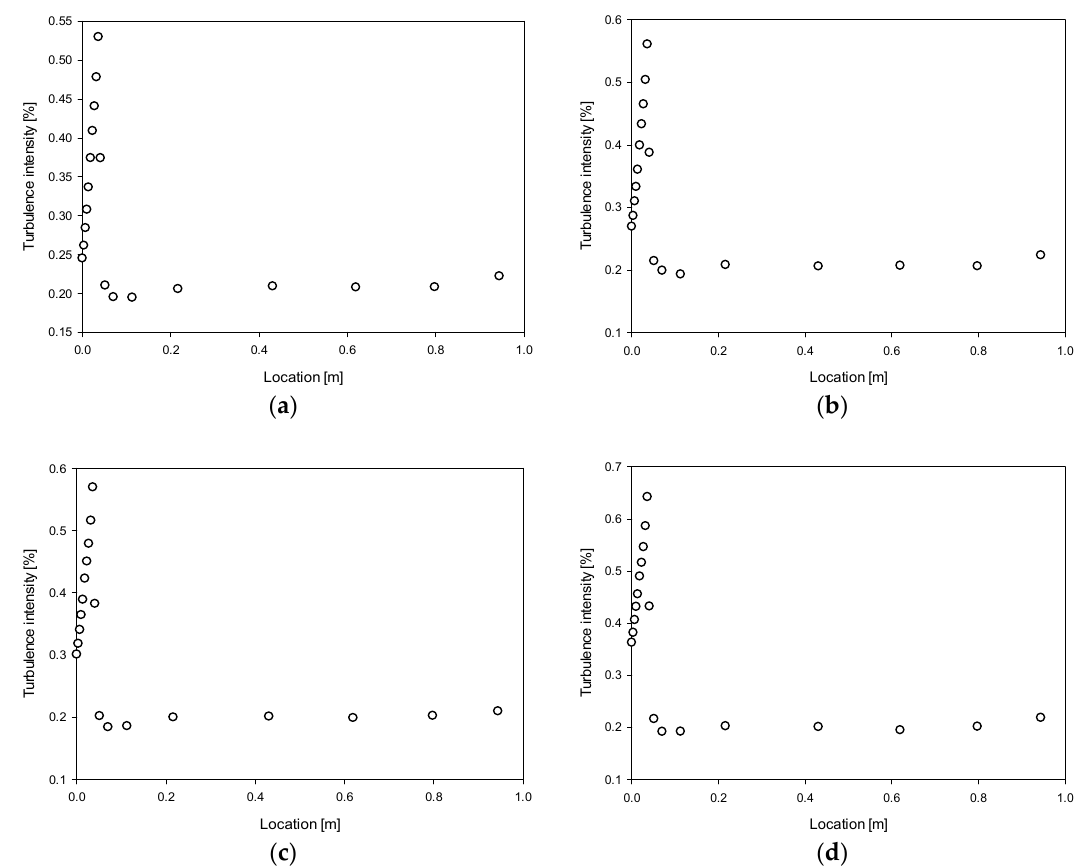
Figure 8. The turbulence intensities obtained by Reynolds stress (RSM) model at different times: ( a ) 150 s, ( b ) 250 s, ( c ) 350 s, ( d ) 500 s (Location 0: discharging point).